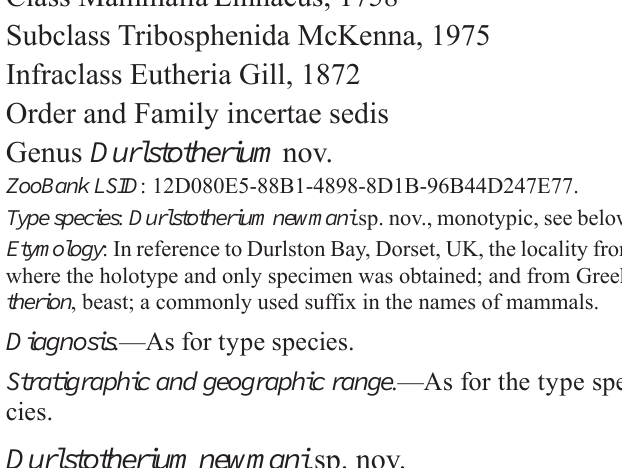
Etymology : In honour of Charlie Newman, recognising his intimate local knowledge, willingly shared, and his help in the field. Fig. 2. Stratigraphic log of part of the Purbeck Group exposed in the northern part of Durlston Bay showing the horizons from which mammal remains have been recovered, and the horizon from which the new speci- mens described here were obtained. Redrawn from Clements (1993) using the author’s “erosional profile” but with additional bed names. Detailed comments on lithologies and palaeontology are contained in the above publication in which all bed numbers bear the prefix